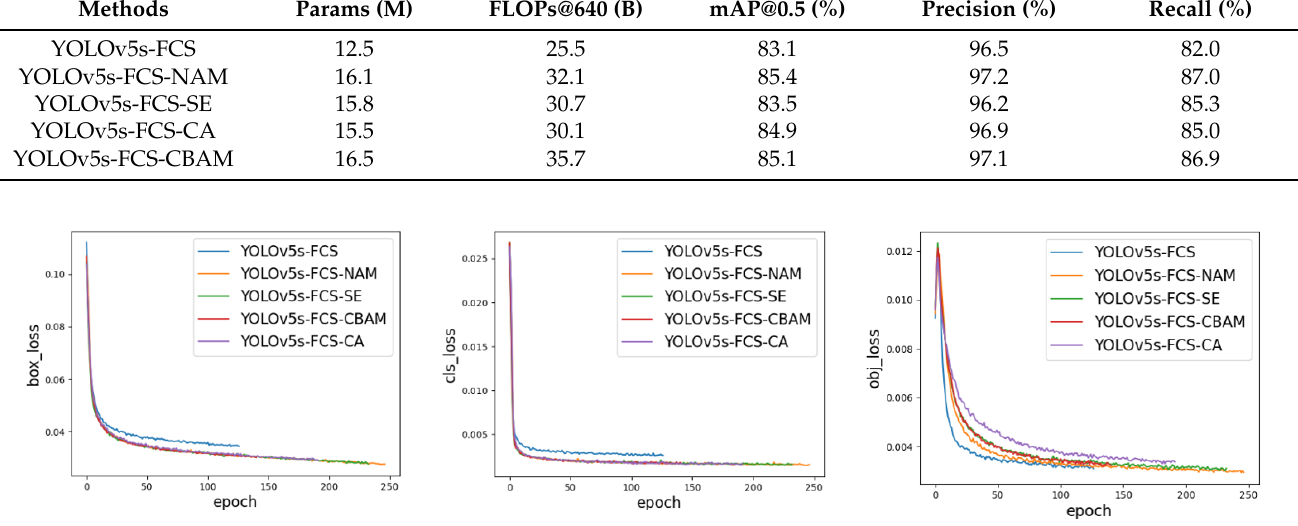
Figure 8. Loss functions for models with different attention